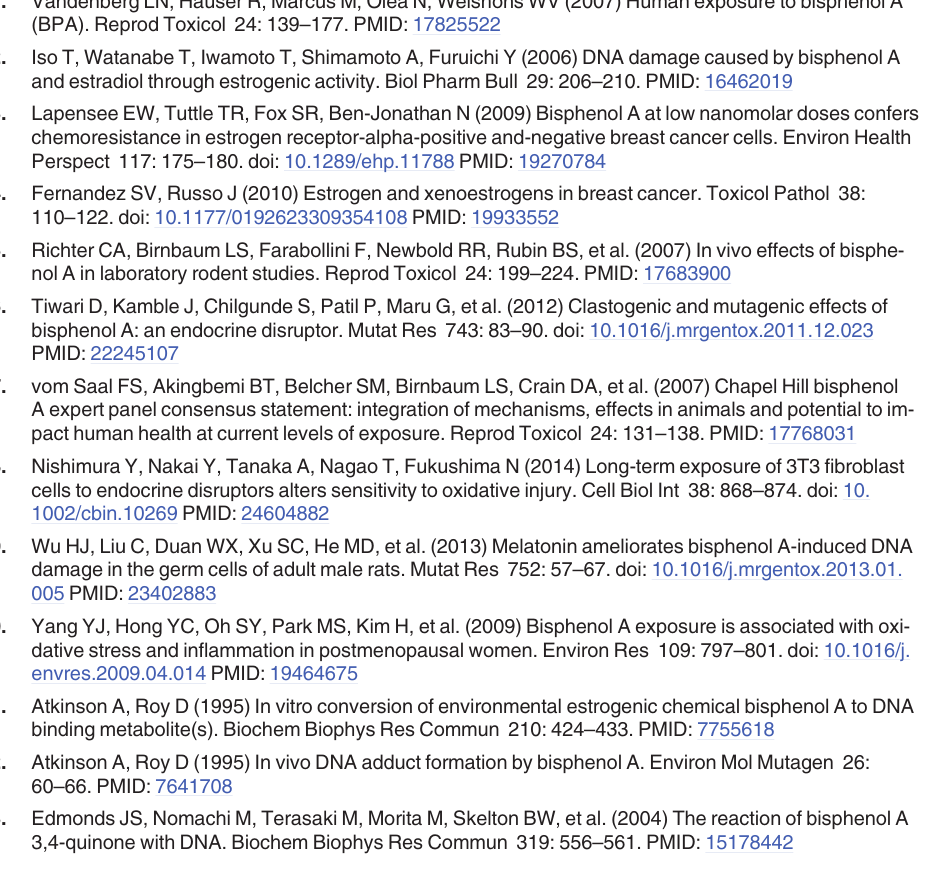
alone, and after co-exposure 3